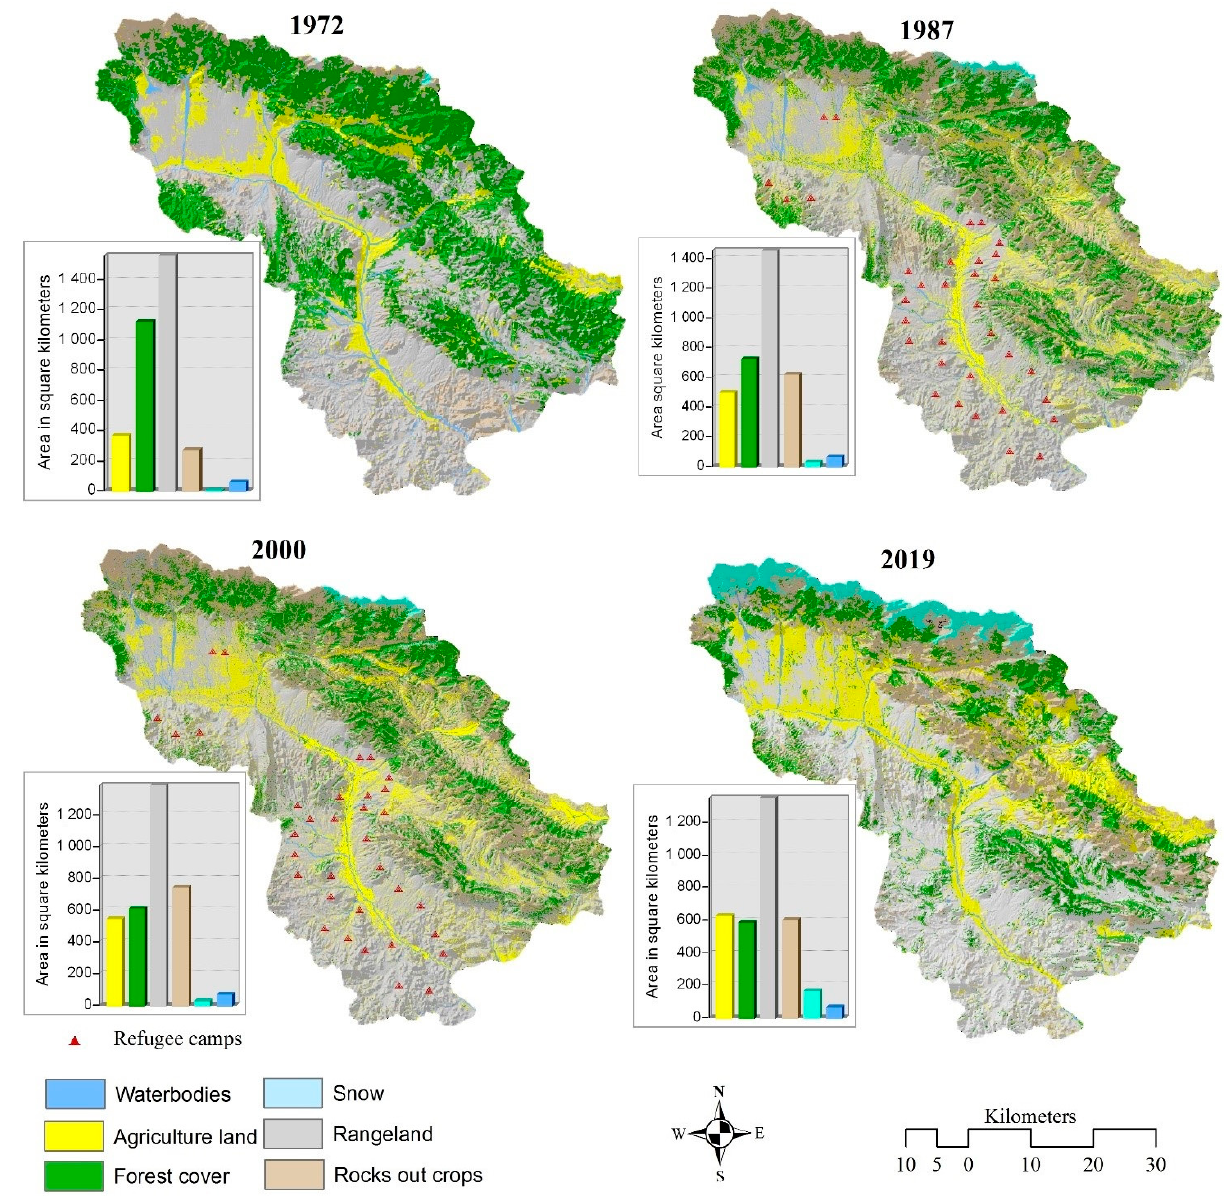
Figure 2. Land use and land cover of District Kurram (1972–2019) with Afghan refugee camps in 1987 and 2000 images. Source: Classified images of 1972, 1987, 2000 and 2019